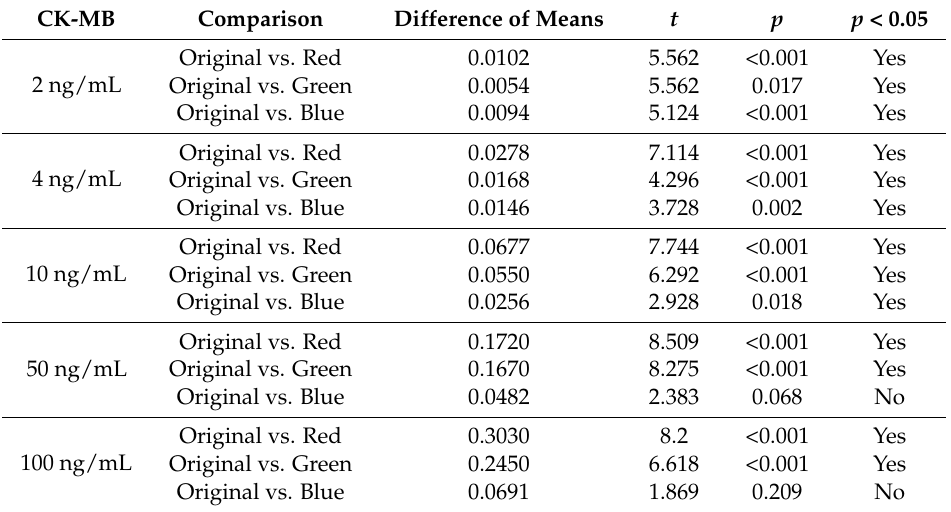
Table 1. ANOVA test results of analysis methods using each color channel of the assay (vs. the method of analysis using original color image). If the p value is greater than 0.05, it means that there is no statistically significant difference in quantitative analysis performance. CK-MB = creatine kinase–muscle/brain. CK-MB Comparison Difference of Means t p p < 0.05 Original vs.